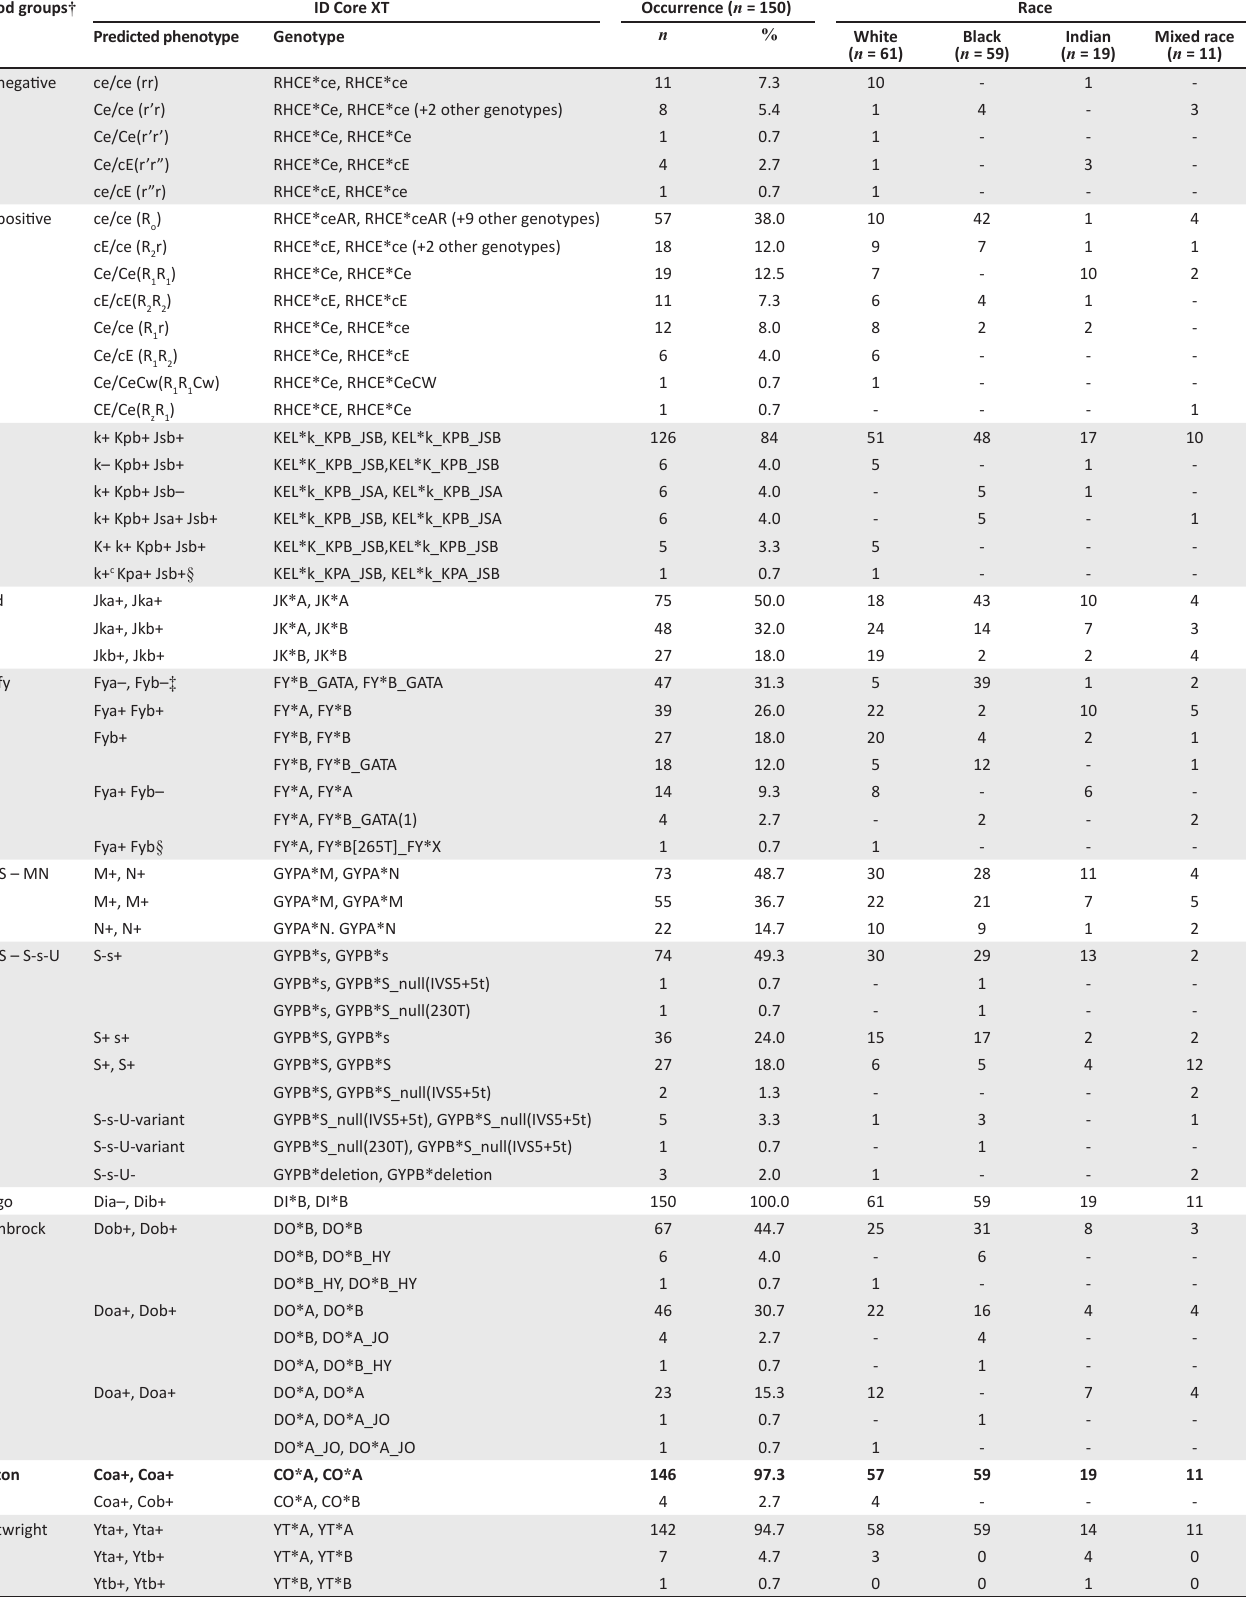
TABLE 1: Percentage occurrence of the ID CORE XT predicted phenotypes and genotypes for 150 South African blood donors genotyped at the South African National Blood Service Immunohaematology Reference Laboratory from January 2015 to August 2016. Blood groups † ID Core XT Occurrence ( n = 150) Predicted